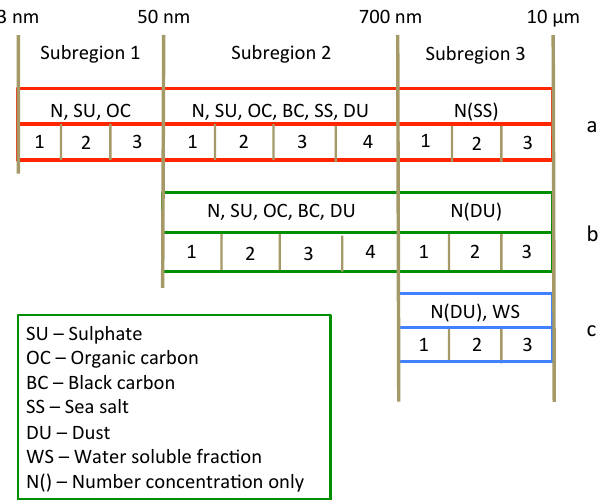
Fig. 1. Schematic of the SALSA sectional structure. There are three parallel sections a, b and c in three subranges, each consisting of three or four sections. Parallel size sections in subclass a are soluble, in subclass b insoluble and in subclass c insoluble, with possibility for soluble coating enabling cloud activation.